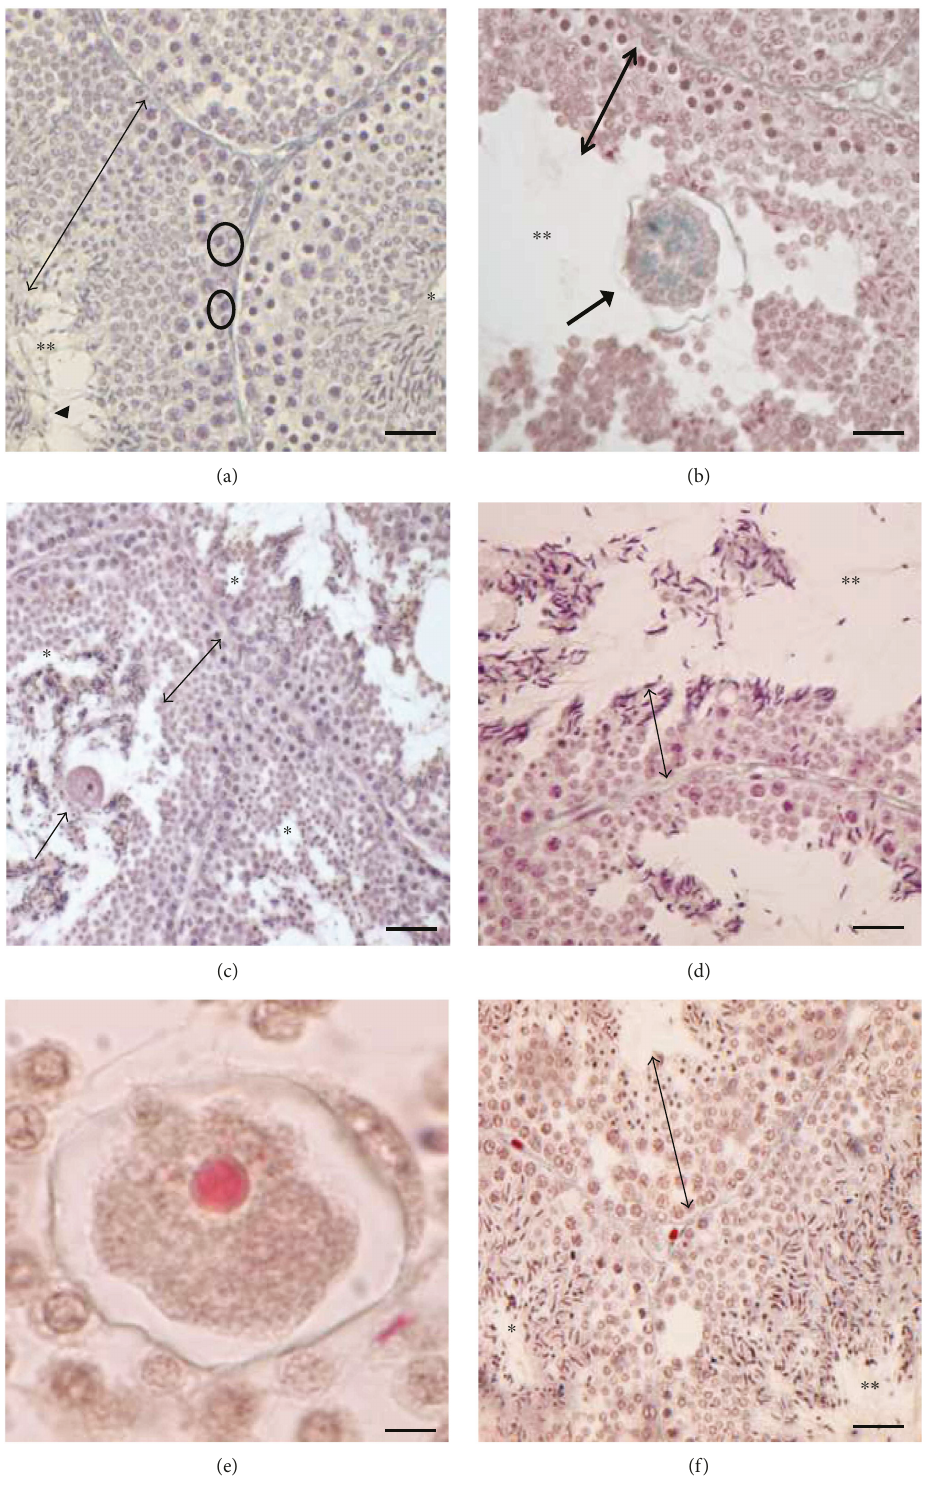
Figure 1: Histology of P. sicula testis. (a) Untreated males, mating period: the seminiferous epithelium is thick ( ↕ ) and full of germ cells in all spermatogenic stages, from spermatogonia ( ○ ) at the basis of the tubules to spermatozoa ( ◄ ) in the restricted lumen ( ∗∗ ). (b) Clomiphene- treated samples: the seminiferous epithelium is reduced in thickness ( ↕ ); in the lumen, some degenerate cells and oocyte-like structures are evident ( ↑ ). (c, d) FSH-treated samples: in the thin seminiferous epithelium, few germ cells and several empty spaces ( ∗ ) are present, and oocyte-like structures ( ↑ ) are also evident. (e) Detail at high magni fi cation of oocyte-like structure. (f) FSH-Clomiphene-treated samples: all stages of spermatogenesis are evident and the epithelium thickness is increased ( ↕ ). The bar is 30 μ